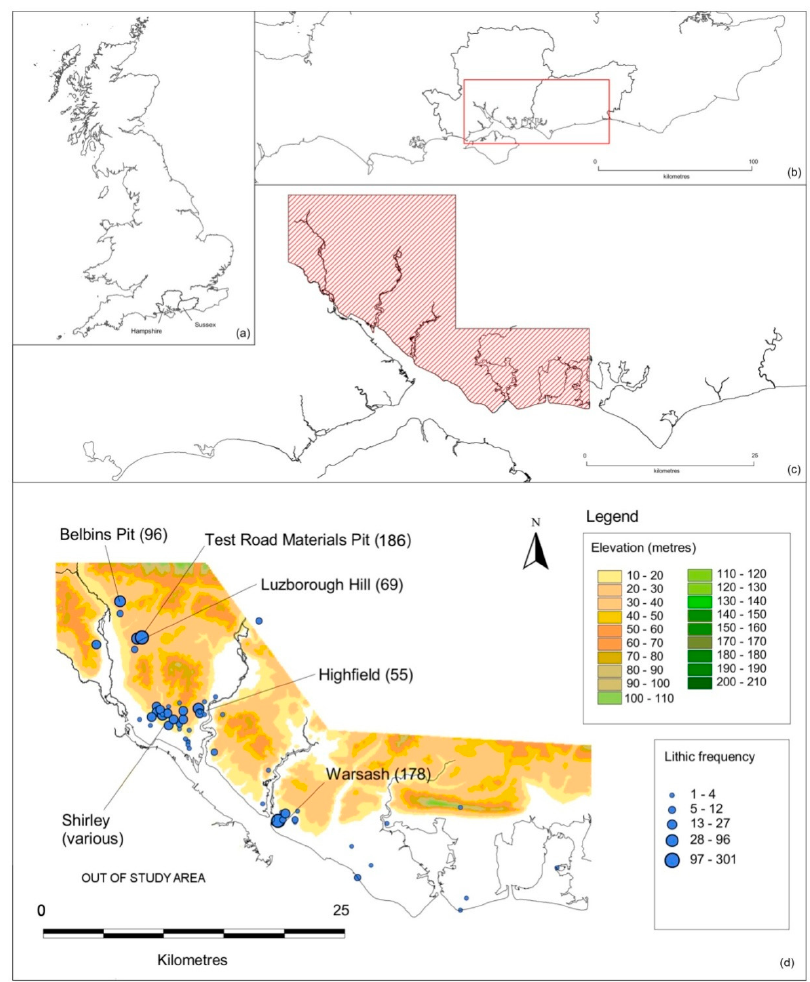
Figure 1. ( a ) Hampshire and Sussex in Southern England; ( b ) the Sussex/Hampshire coastal corridor catchment area; ( c ) Eastern Solent-focussed study area; ( d ) Palaeolithic sites of the study area, showing modern-day elevation above sea level, mapped by frequency of lithics discovered at each site. Highest lithic yield sites are named, with lithic counts following in parentheses.